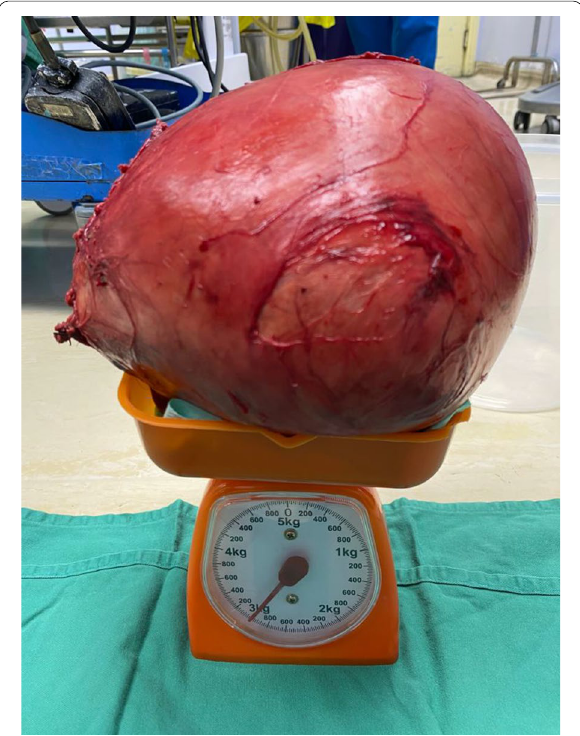
with dilated veins over right scrotal skin